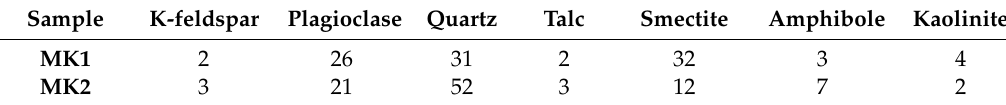
Figure 4. XRD patterns of raw clay materials. Table 2. Mineralogical composition of raw clay materials